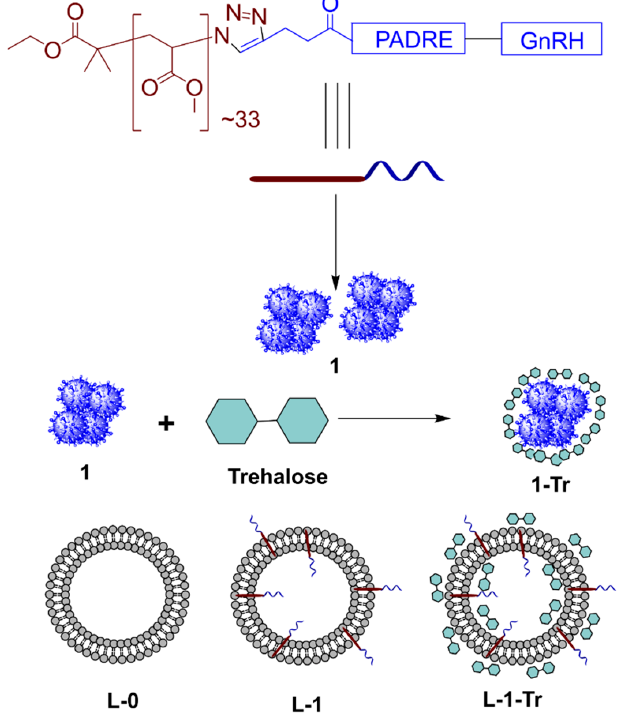
Figure 1. Vaccine candidate 1 and its formulations: 1-Tr —conjugate 1 formulated with trehalose; L-O —blank liposomes; L-1 —conjugate 1 anchored to liposomes; L-1-Tr —conjugate 1 anchored to liposomes and formulated with trehalose.